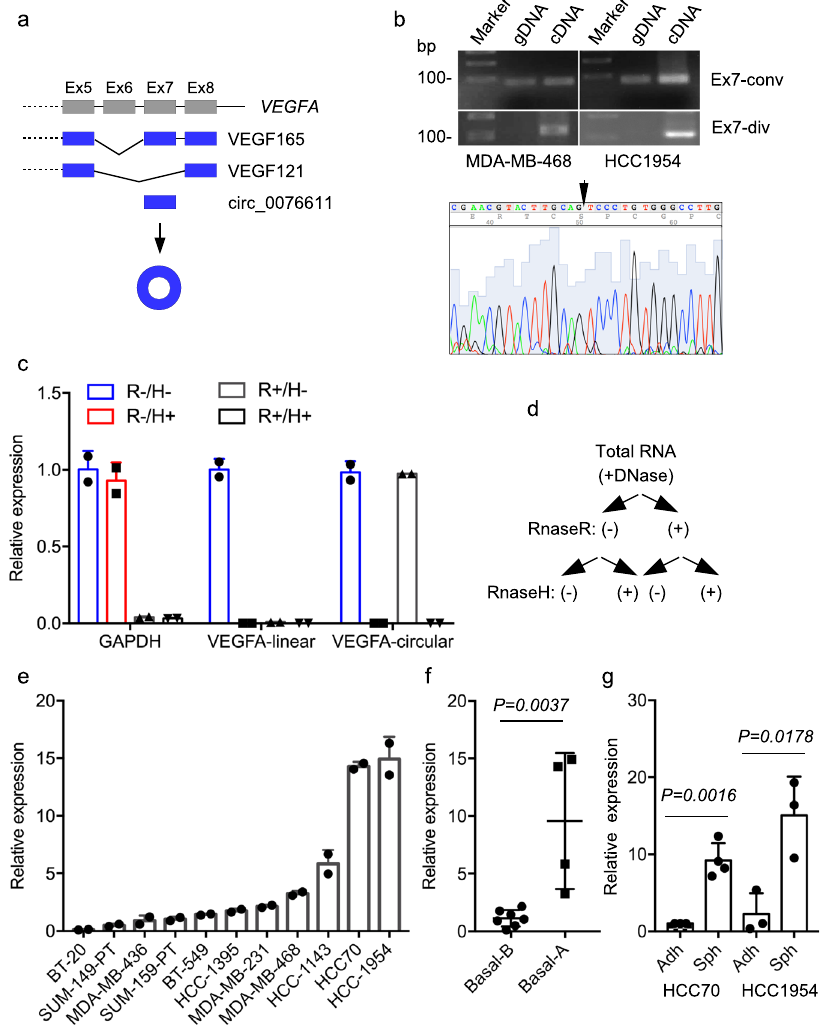
Fig. 1 Circ_0076611 is expressed in triple-negative breast cancer cell lines. a Schematic illustration of VEGFA exons 5 to 8. Inclusion or exclusion of exon 7 in alternative splicing events causes to the formation of the two major isoforms, VEGF165 or VEGF121, respectively. Back-splicing of Exon 7 leads to the formation of a circular RNA, circ_0076611. b RT-PCR analysis of VEGFA Exon 7 using convergent (Ex7-conv) or divergent (Ex7-div) primers and genomic DNA (gDNA) or cDNA as templates in the indicated cell lines. The presence of circ_0076611 back-splice junction sequence has been veri fi ed by Sanger sequencing of PCR products (lower panel). c , d RT-qPCR analysis of GAPDH, VEGFA linear (VEGF165) and VEGFA circular (circ_0076611) transcripts on total RNA extracted from MDA-MB-468 cells and treated or not with RNaseR and/or RNaseH, in the presence of a VEGFA Exon 7 antisense oligonucleotide. Bars indicate standard error. e RT-qPCR analysis of circ_0076611 in the indicated breast cancer cell lines. Bars indicate standard error. f Box plot representing the expression of circ_0076611, evaluated by RT-qPCR, in breast cancer cell lines belonging to Basal A and Basal B molecular subtypes. * p ≤ 0.05 (unpaired, two-tailed Student ’ s t test). g Expression of circ_0076611, evaluated by RT-qPCR, in the indicated breast cancer cell lines grown in adhesion (Adh) or as mammospheres (Sph). Data are presented as mean plus standard deviation. * p ≤ 0.05, ** p ≤ 0.005 (unpaired, two-tailed Student ’ s t test). Results from at least three biological replicates are shown. Bars indicate standard